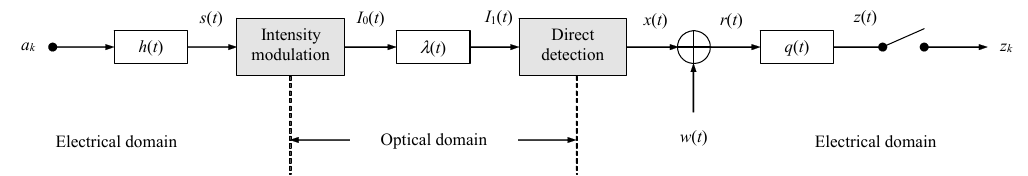
Figure 2. Signal model for intensity modulation and direct detection (IM/DD) optical links.